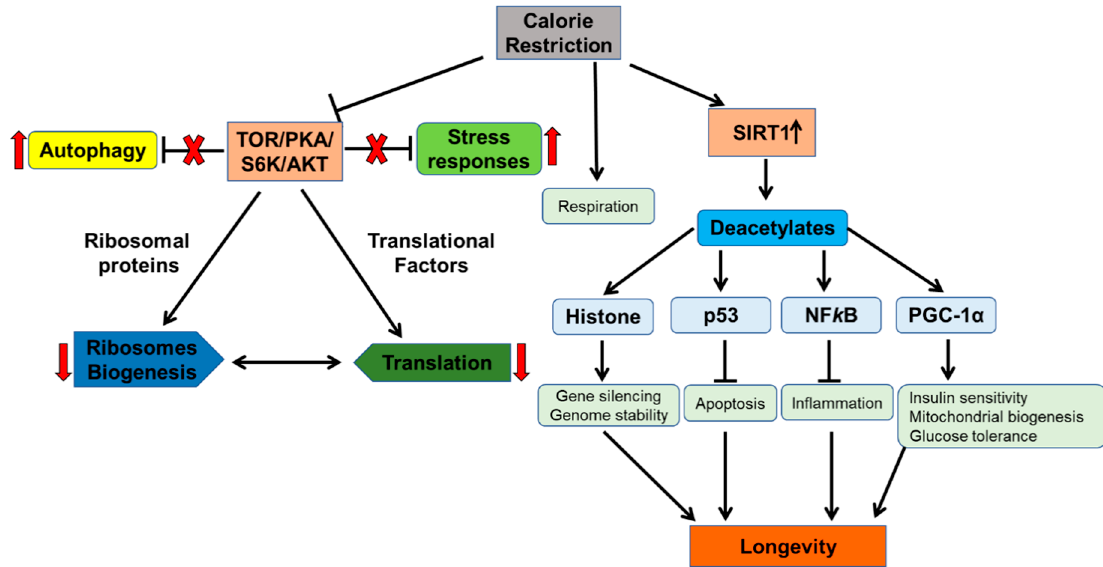
Figure 4. Schematic representation of pathways associated with caloric restriction and their downstream effects. The figure represents the conserved underlying response of caloric restriction and how this modulates aging and associated pathways. CR inhibits TOR functions, which result in decreased S6K activity and decreased protein translation, along with increased autophagy. Decreased ribosome biogenesis and translation then inhibits angiogenesis and cell-cycle progression. CR promotes SIRT1 activity which results in the deacetylation of many downstream targets which maintain heterochromatin, establish genomic stability, prevent the expression of pro-inflammatory genes, and decrease cell growth and proliferation, ultimately promoting longevity.